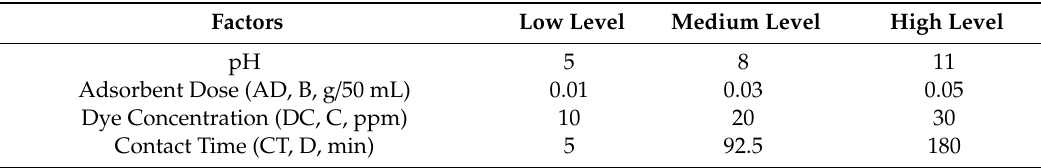
Table 3. Independent factors and their levels together with the observed and predicted dependent variable and the FCCCD